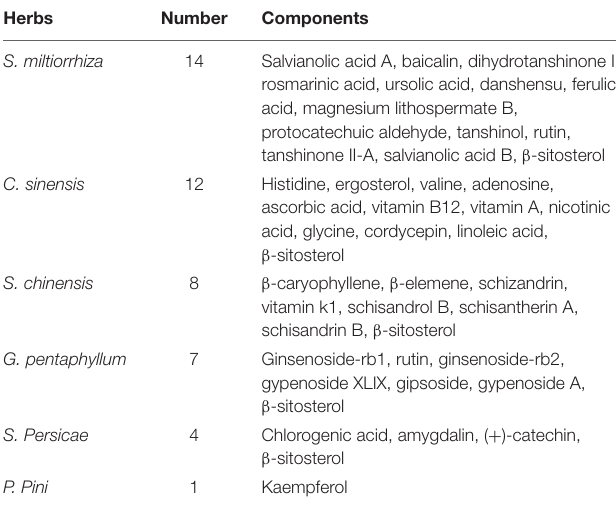
TABLE 1 | Active components identified by in six herbs.